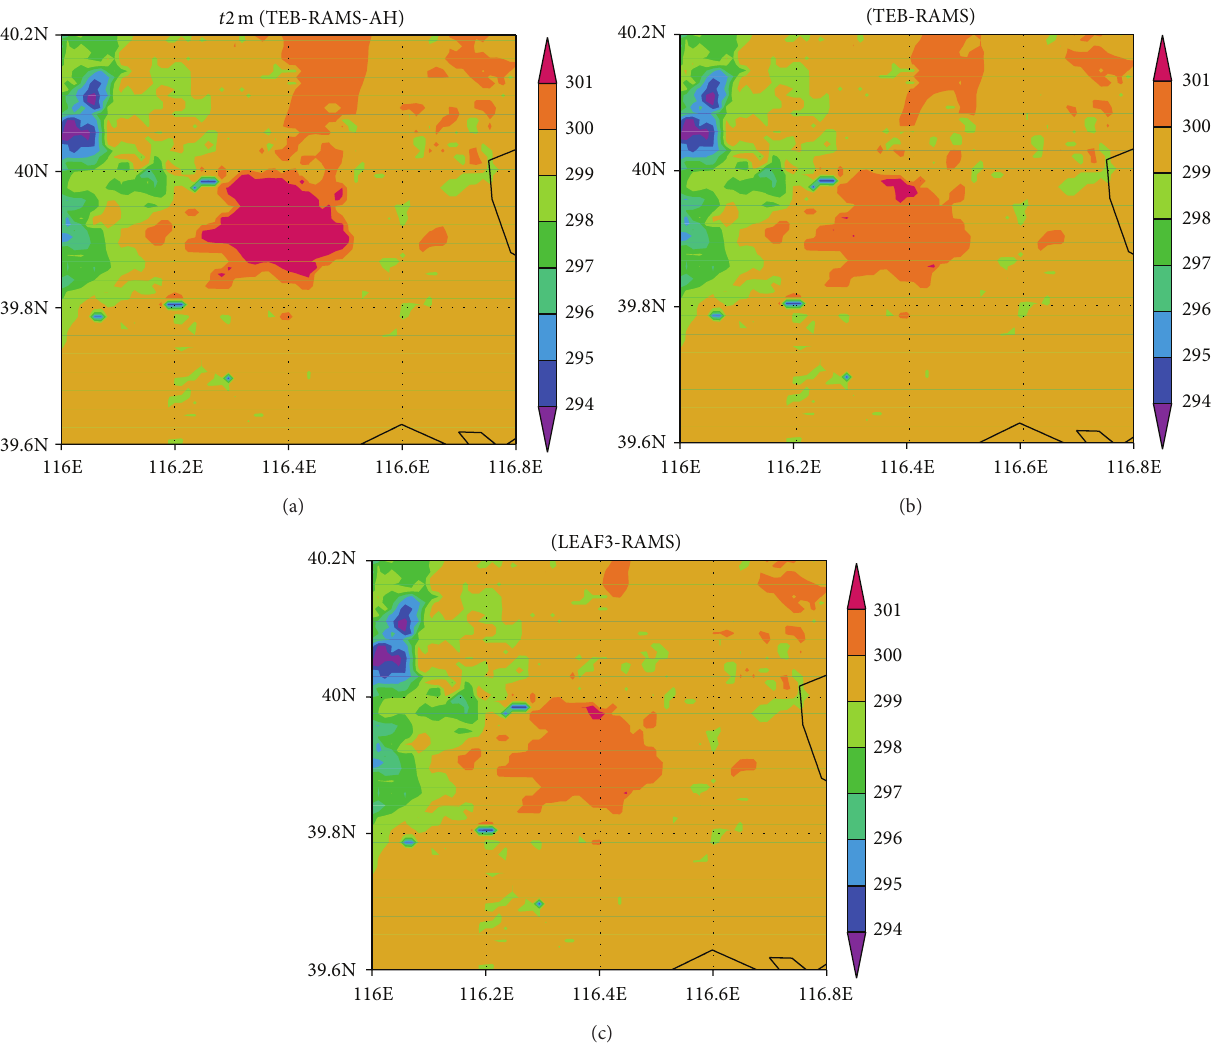
Figure 5: (a) Spatial distributions of model simulated daily mean 2m air temperature (K) from 0000 UTC (1400 LST) 01 to 0000 UTC 02 July 2003 using the TEB-RAMS-AH model. (b) Same as in (a) without AH emission. (c) Same as in (a) but employing the LEAF3-RAMS